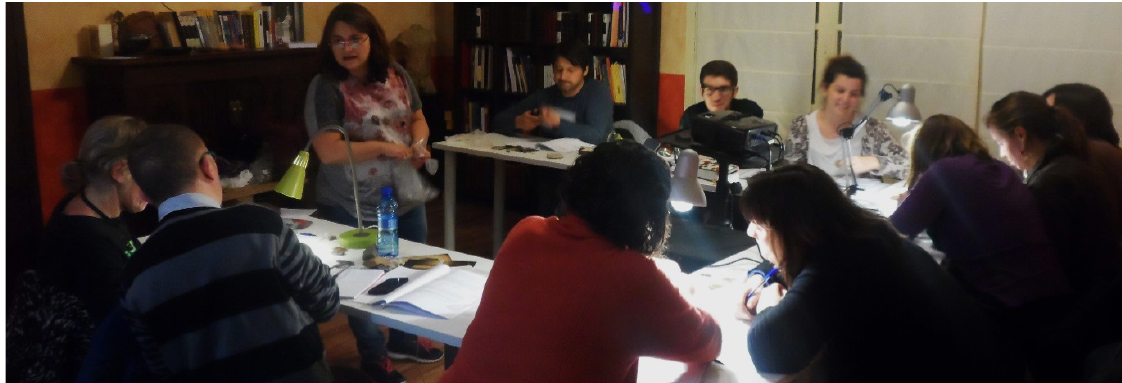
Figure 2. Development of the course. (Photograph provided by Dibujantes de Arqueología,